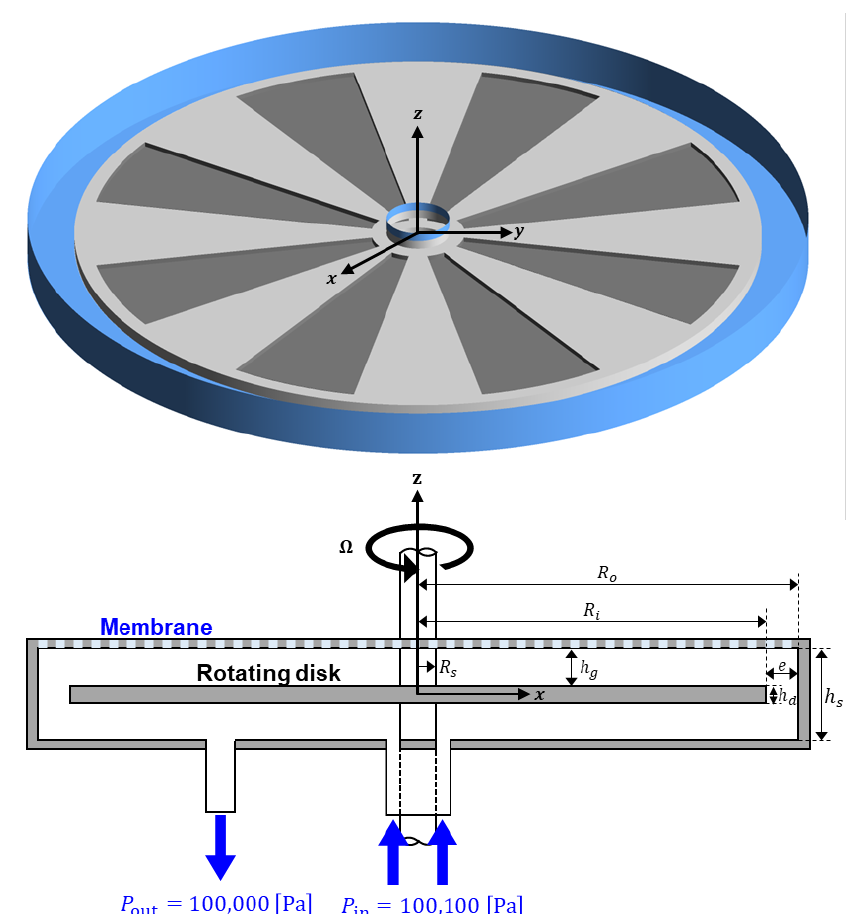
Figure 1. The schematic representation of the dynamic filtration system consisting of a disk (in this figure, with eight engraved patterns) rotating with a constant angular velocity about the 𝑧 -axis, and a stationary housing. The feed is introduced through an annular-shaped inlet and exits the filtration system through an outlet. A constant pressure difference ( ∆𝑃 𝑖𝑜 = 𝑃 𝑖𝑛 − 𝑃 𝑜𝑢𝑡 = 100 Pa) is applied between the inlet and outlet. A circular flat membrane with the radius 𝑅 𝑜 is fixed on top of the housing.